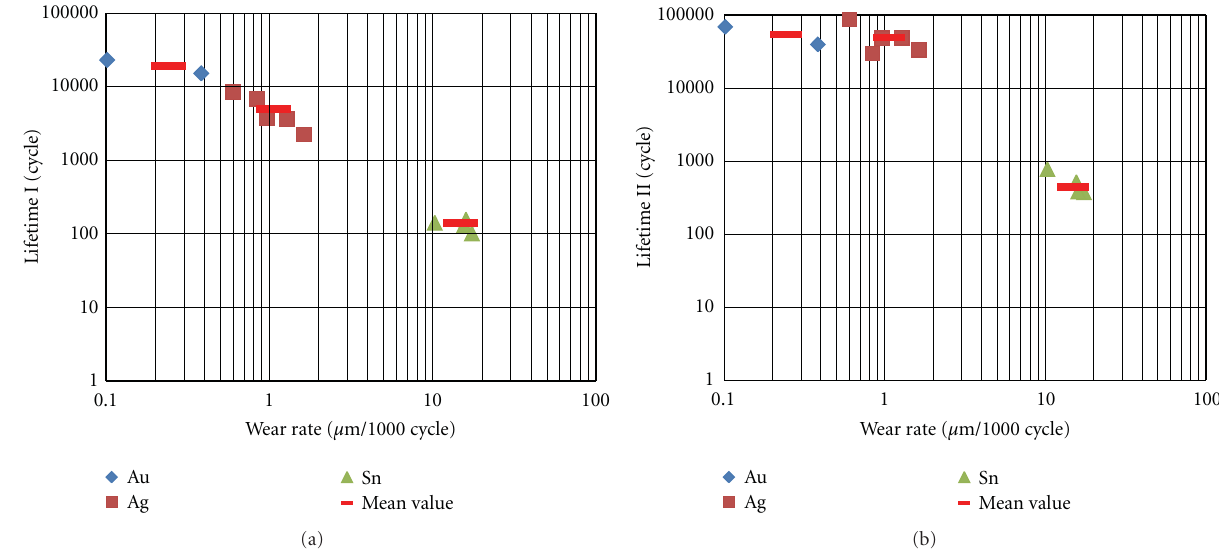
Figure 6: (a) Correlation between the rate of wear and lifetime I of electrical contacts with di ff erent coating materials. (b) Correlation between the rate of wear and lifetime II of electrical contacts with di ff erent coating materials.